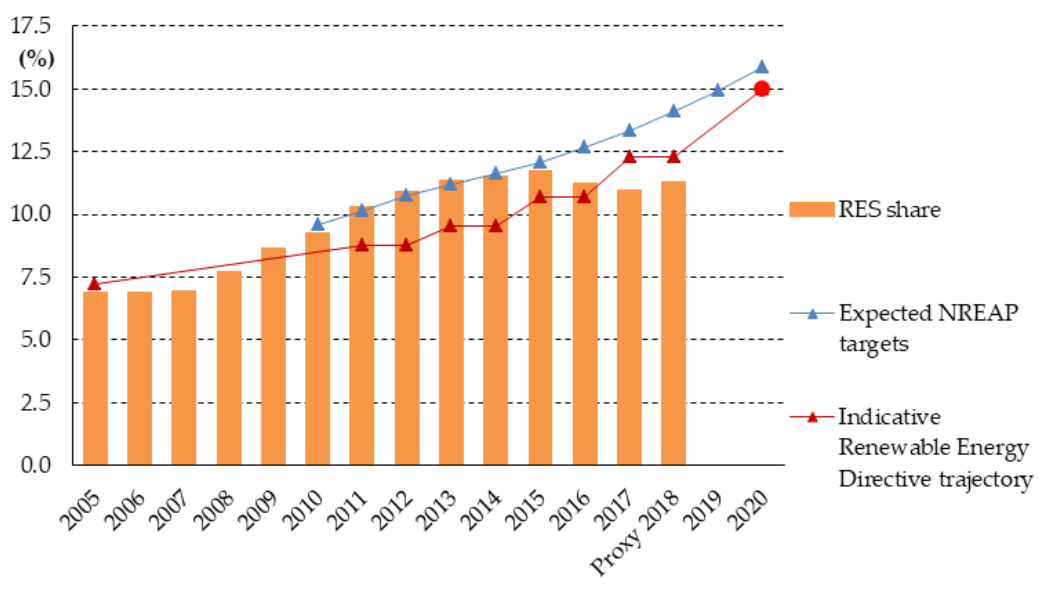
Figure 6. Progress towards renewable energy target, in (%) [38,39].